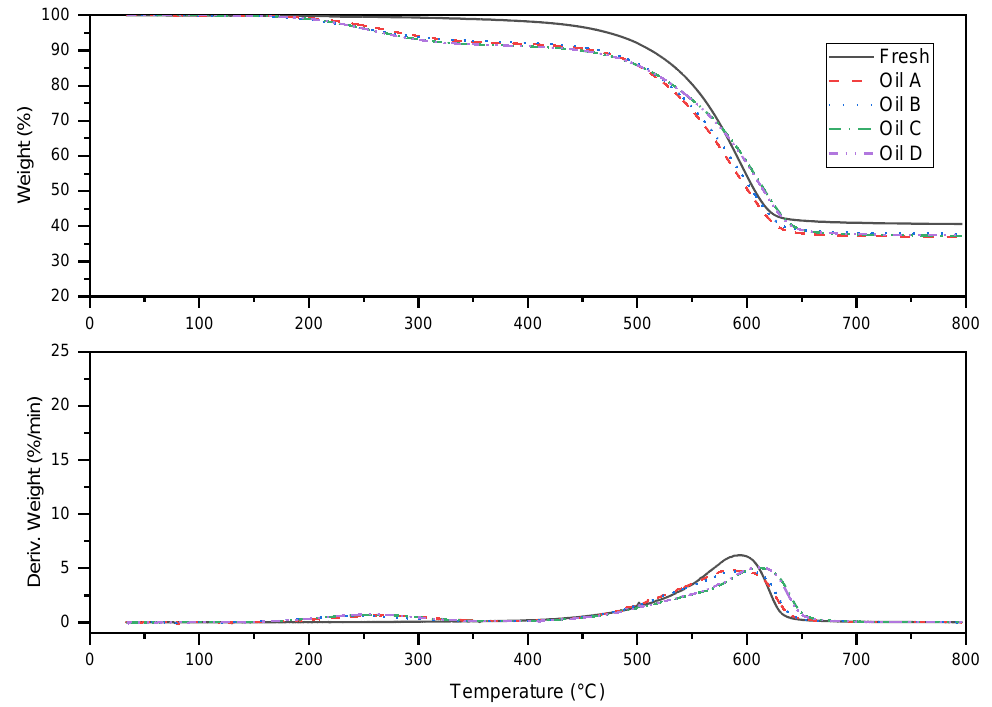
Figure 13. TGA (above) and DTGA (below) curves expressed as mass percentage and mass percentage over time, for fresh and 168 h aged